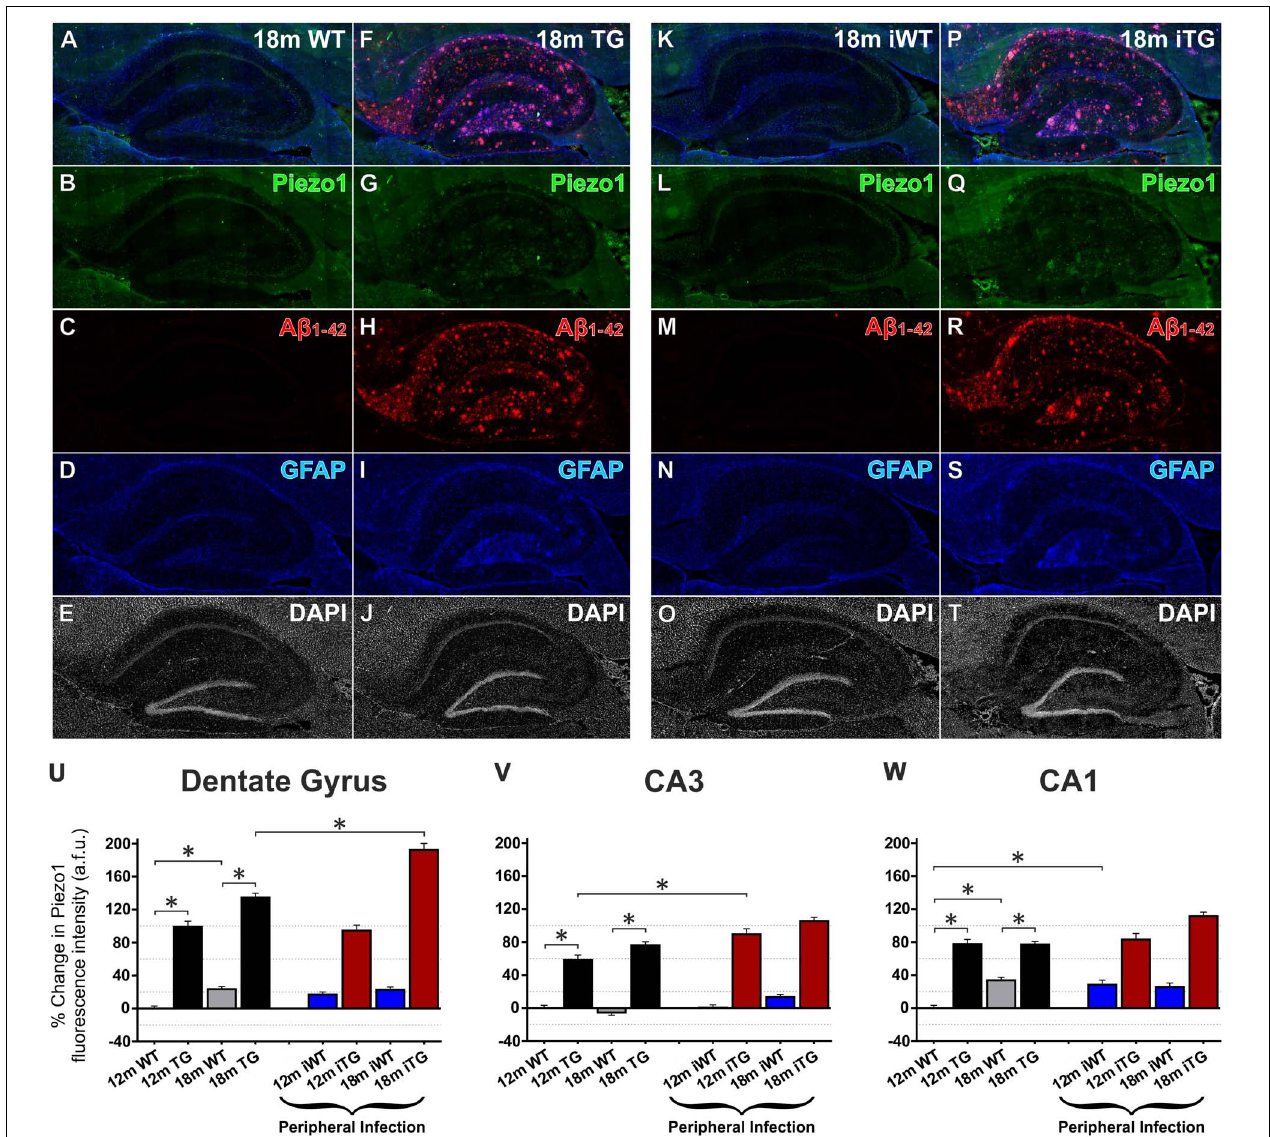
FIGURE 6 | Aging, A β 1 − 42 pathology and peripheral infection upregulate Piezo1 expression in the hippocampus of TgF344-AD rats. Sagittal sections (lateral − 1.9 mm) of WT Fisher and TgF344-AD rat brains were immunofluorescently stained for Piezo1 (N-terminal antibody), conformation-specific A β 1 − 42 , GFAP, and DAPI. Shown are representative images of the hippocampus of an 18-month wild-type (18m WT) rat (A–E) , an 18-month TgF344-AD 18m TG (F–J) , an 18-month WT with infection (18m iWT) (K–O) , and an 18-month TgF344-AD with infection (18m iTG) (P–T) . TgF344-AD rats with and without an infection show clear upregulations of GFAP (I,S) in hippocampal areas with dense amyloid deposition (H,R) , particularly the hilus, the outer molecular layer of the dentate gyrus, and the stratum oriens of the CA1. Moreover, amyloid plaques surrounded by a dense meshwork of GFAP-positive astrocytes generally showed concomitant upregulations of Piezo1 expression, particularly in 18m TG rats with or without an infection (G,Q) . Next, changes in Piezo1 expression with age, infection and genotype were quantified in the neuronal cell body layers of the dentate gyrus (U) , CA3 (V) , and CA1 (W) . Piezo1 expression increased from 12- to 18-months in WT rats in the DG and CA1, but not CA3 neurons. A much more potent trigger of Piezo1 expression in the hippocampus, however, was genotype with TgF344-AD rats expressing much larger levels of Piezo1 in the DG (U) , CA3 (V) , and CA1 (W) at 12-months of age. There were no further increases in Piezo1 expression in 18-month old TgF344-AD rats. However, peripheral infection caused a significant increase in Piezo1 expression in the dentate gyrus (U) of TgF344-AD rats (18m iTG). Data were normalized to 12m WT values for each hippocampal region and are represented as the mean ± SEM of the percentage change from the 12m WT groups. Three-way ANOVAs with Holm-Sidak post hoc tests were performed to test for interactions between age, genotype, and peripheral infection. ∗ Represents a change of > 20% and a p -value < 0.01. There were 5–6 rats per group and 2–3 brain sections per animal. Ten ROI were analyzed per hippocampal region per section, i.e., 100–180 ROIs analyzed per